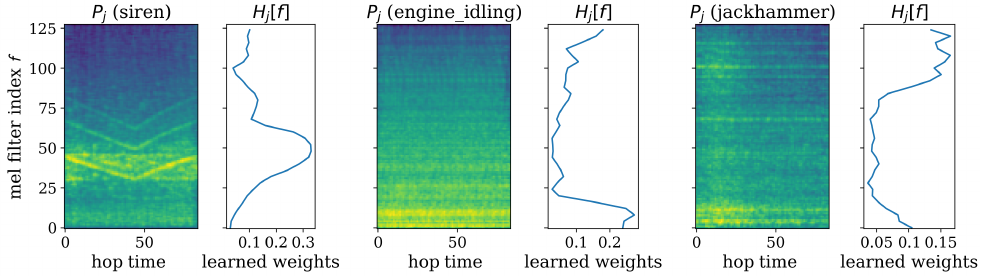
Figure 7. Examples of the learned kernel, H , of the weighted sum layer from the similarity function.